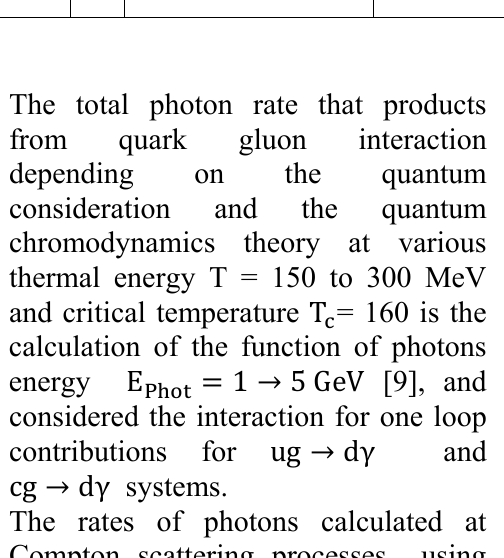
Table 1: Theoretical estimation of the effective strength coupling (cid:2235) =160 Mev for (cid:2203)(cid:2189) → (cid:2186)(cid:2237) and (cid:2185)(cid:2189) → (cid:2186)(cid:2237) temperature (cid:2176) (cid:2185)